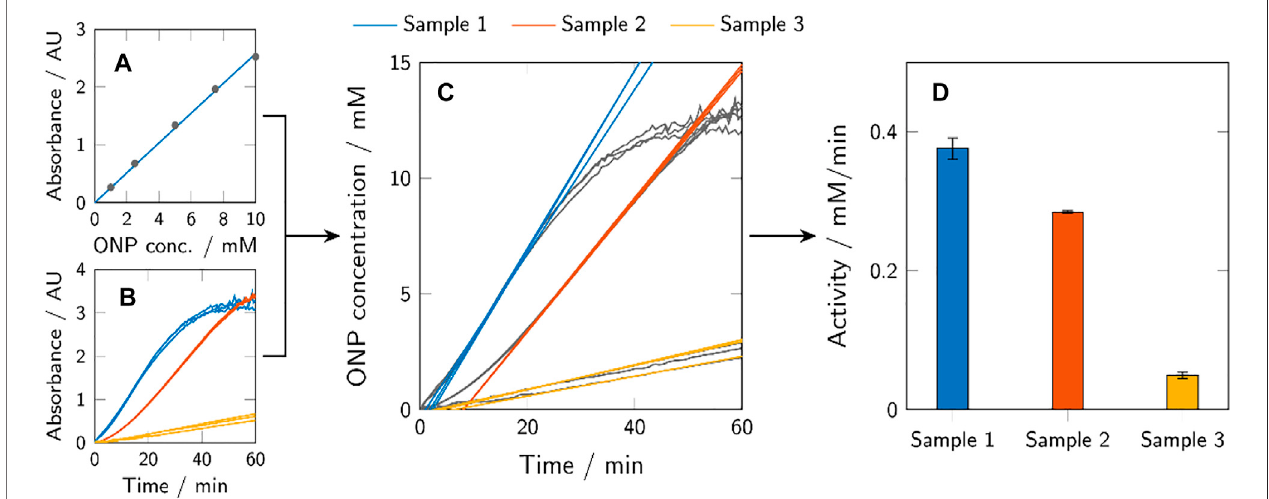
FIGURE3| Graphicrepresentationoftheactivity assayevaluationmethod. ONPcalibrationcurveswerecalculatedfromknownONPsamples (A) totransform the obtained absorbance data of the activity assays (B) to ONP concentration pro fi les over time (C) . The maximum activity of a sample ( a max ) corresponds to the maximum slope of the respective curve and was determined using a 12 min rolling-window analysis. The obtained values of the maximum activity were presented using bar plots (D) . Depicted here are generic samples.